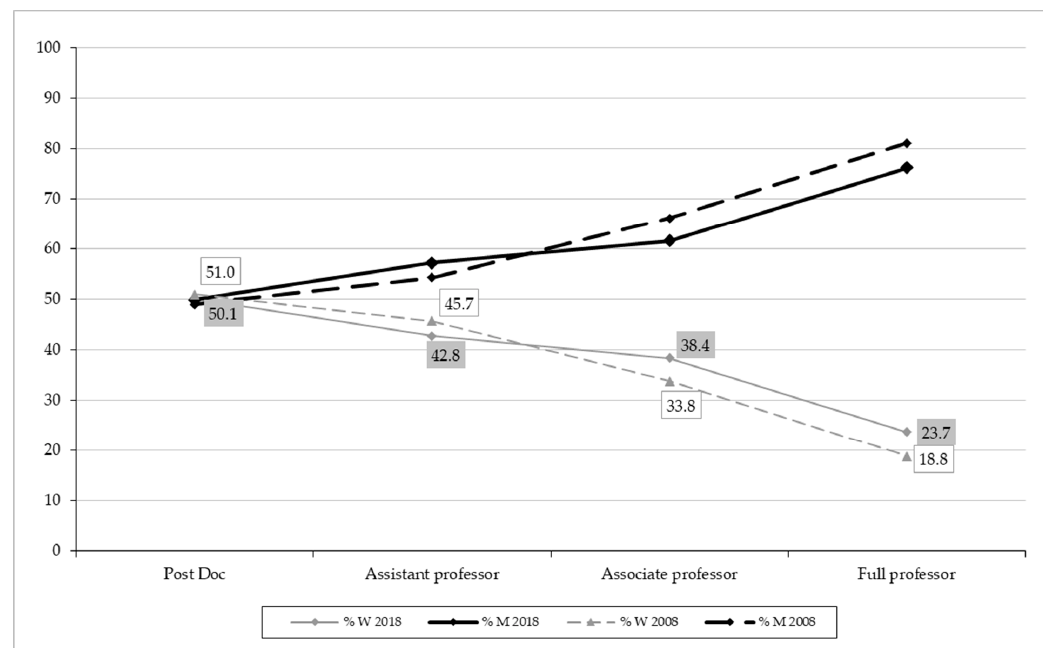
Figure 1. Academic staff by gender and rank, Italy, 2008 and 2018, stock. Source : Authors’ elaboration on Ministry of Education, University, and Research (MIUR) data.